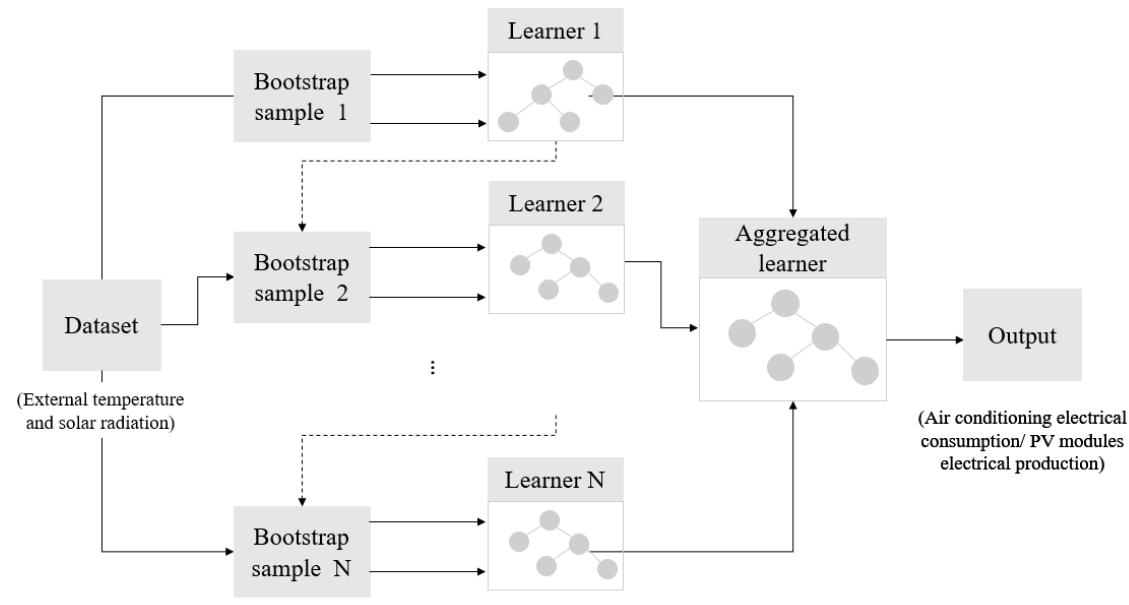
Figure 5. Boosting trees model.